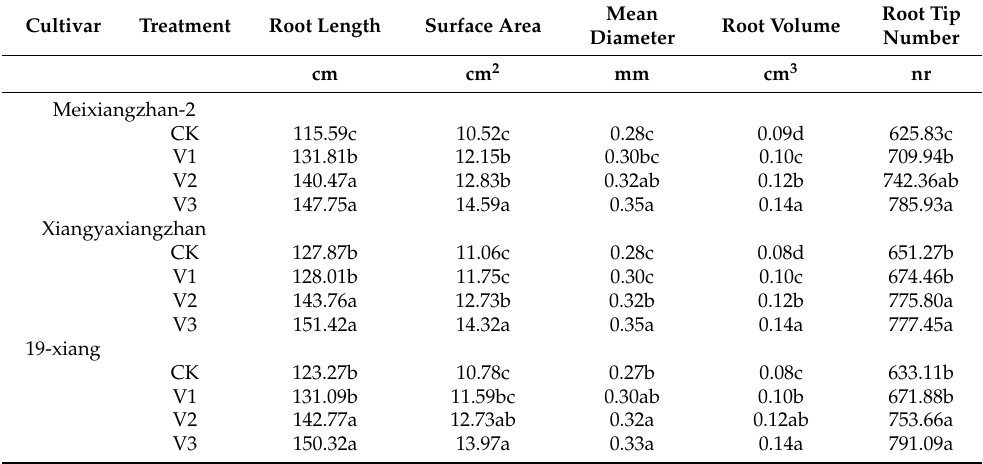
Table 2. Effects of vermicompost incorporation on root characteristics of fragrant rice seedlings. Cultivar